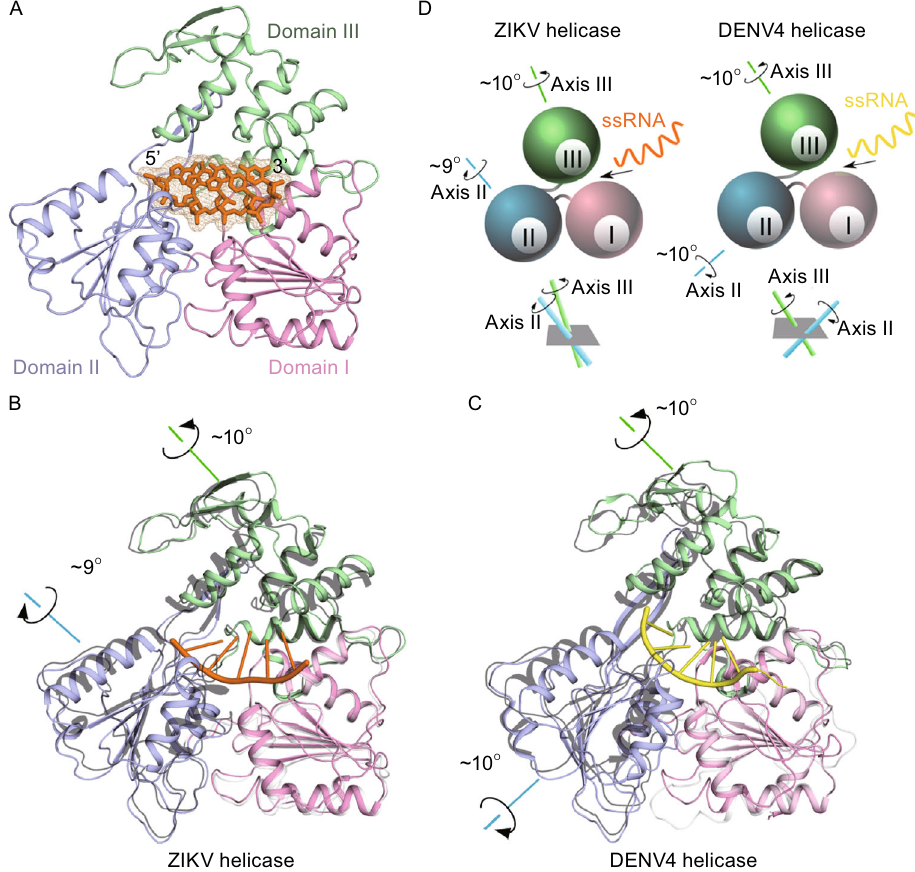
Figure 3. Structure of the ZIKV helicase in complex with RNA. (A) Cartoon representation of overall fold of the ZIKV helicase- RNA complex with three domains colored and marked respectively. The ssRNA is shown in orange sticks and meshes. (B) Overlay of the ZIKV helicase-RNA complex structure and its apo form (grey). The RNA is shown in orange. (C) Overlay of the DENV4 helicase- RNA complex structure and its apo form (grey). The RNA is shown in yellow. The rotations of domain II and III upon RNA binding are depicted accordingly. (D) Schematic illustration of the different modes of domain rotations for ZIKV and DENV4 helicases upon